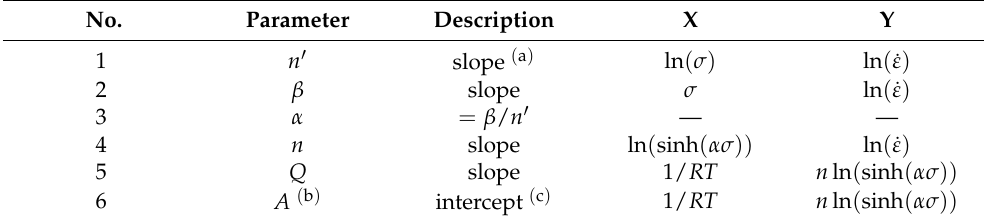
Table 1. The conventional 6-step procedure for estimating the parameters of Equation (2) at any given